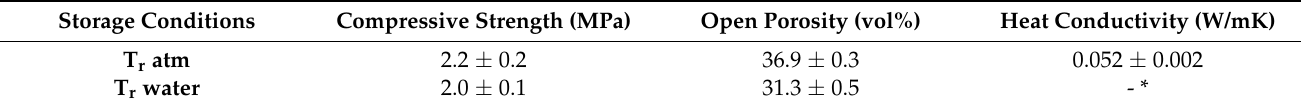
Table 6. Effect of the storage conditions on the physical properties of